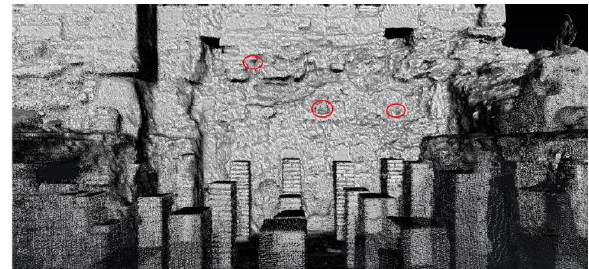
Figure 9 . Radiance scaling visualization of the 3D point cloud. Identified hole features (intended to hold in place the spacer plugs)